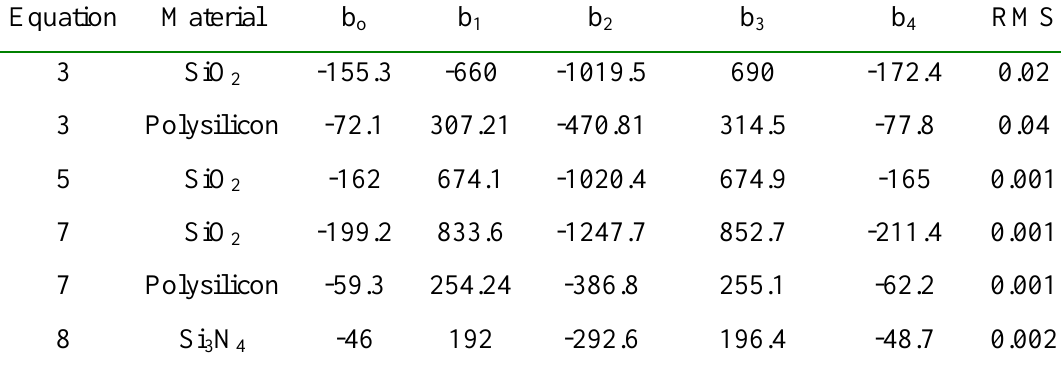
Table 4. A list of polynomial equations constants and the average RMS of curve fitting